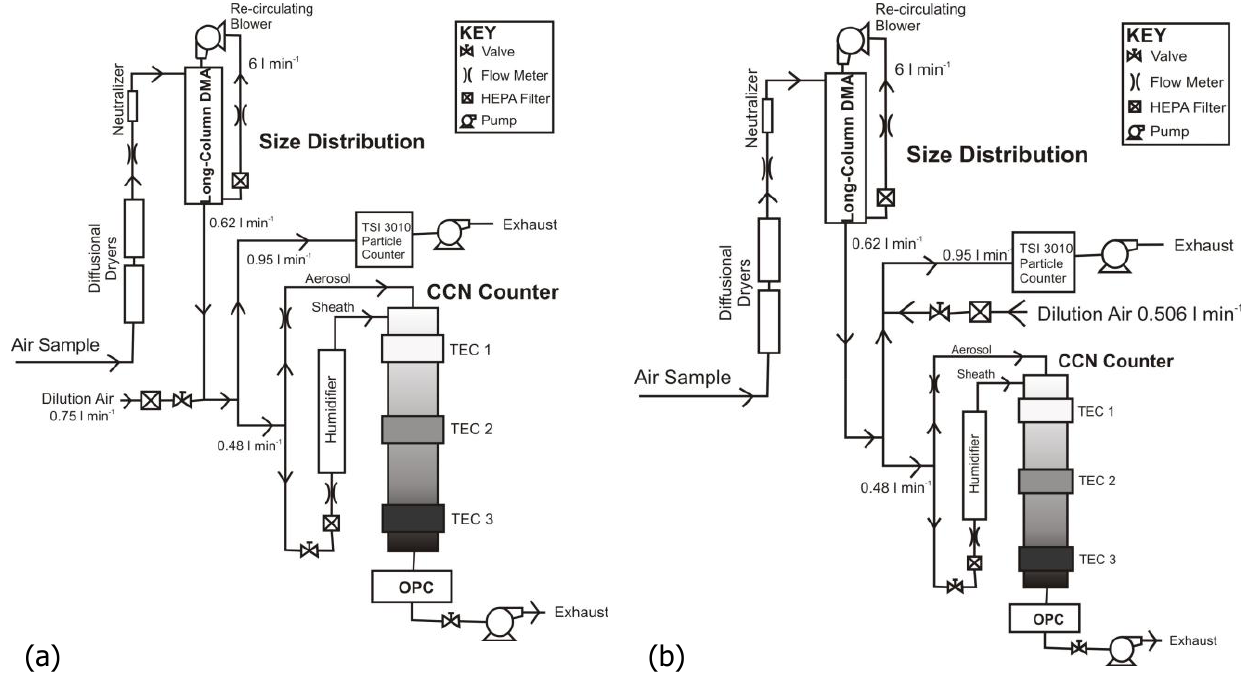
Fig. 2. Schematic of the setup used for the size-resolved CCN